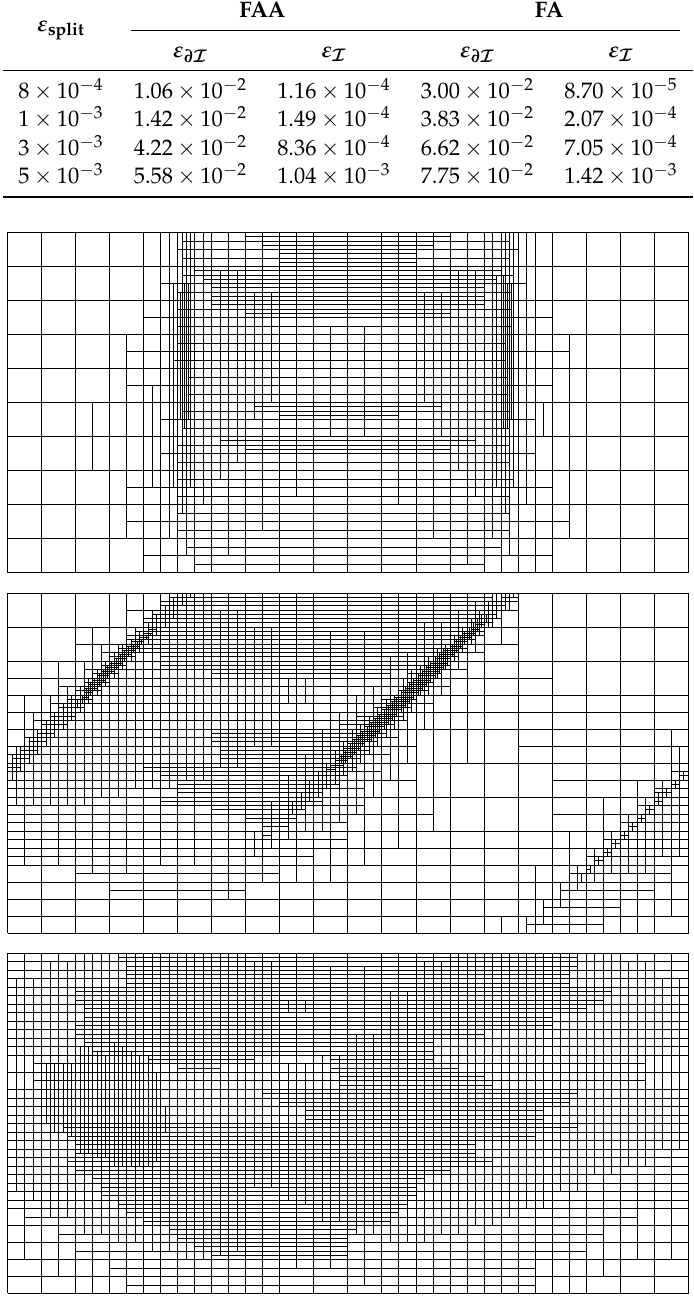
Table 1. Relative errors ε ∂ I and ε I for different values of the splitting accuracy ε split . The results correspond to the linearized forward-adjoint approach (FAA) and the linearized forward approach (FA).